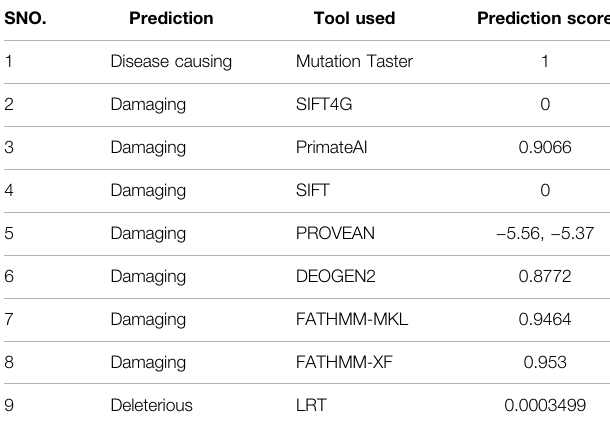
TABLE 3 | Depicting pathogenicity of the identi fi ed homozygous mutant (c.1010C > T; p.Ser337Leu) by using different online software.